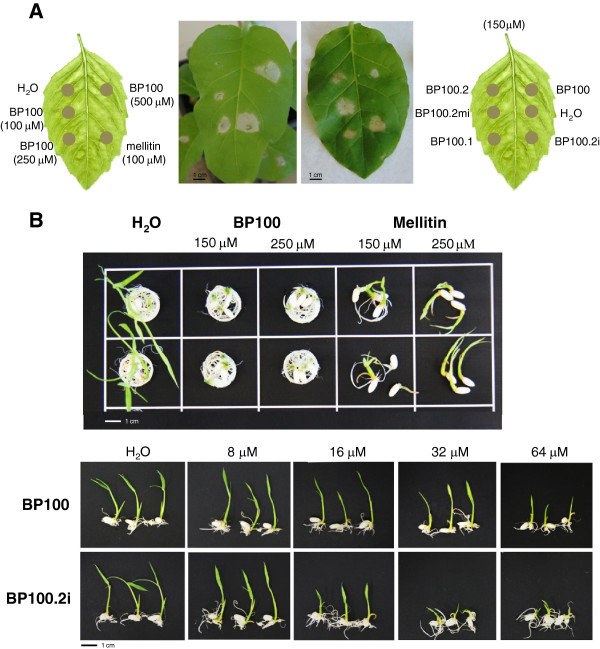
Phytotoxicity of chemically synthesized BP100 derivatives.(A) Representative examples of tobacco leaves, three days after inoculation with H2O, BP100, BP100 derivatives and mellitin. (B) Inhibition of germination assay. Top, representative examples of rice Senia seeds germinated for 7 days in H2O or high concentrations of BP100 and mellitin. Bottom, representative examples of rice Senia seeds germinated for 7 days in H2O or decreasing concentrations of BP100 and BP100.2i. Scale bars: 1 cm.